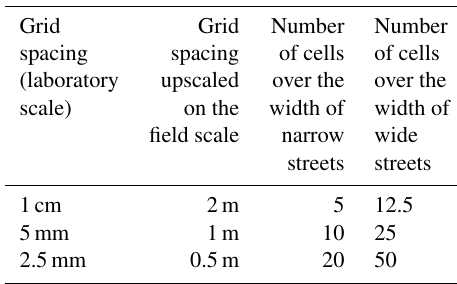
Table 4. Considered grid sizes and corresponding resolution ob- tained on the field